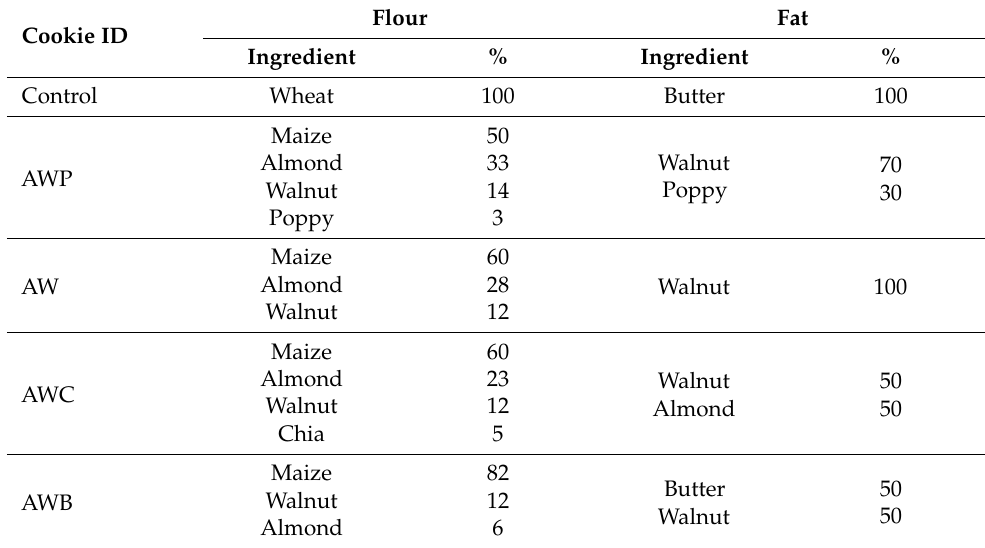
Table 3. Flour and fat source used in the formulation of the cookies elaborated. The percentage of flour and fat refers to the total quantity of flour and fat